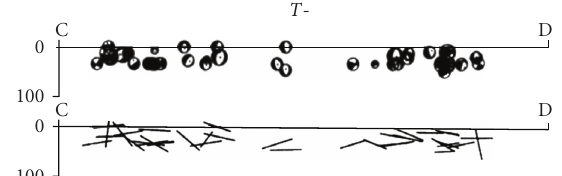
Figure 7: Projections of the vertical section along the line CD near the NW-SE direction for equal area projection diagrams and T-axes of focal mechanism solutions of events (1933–2003, M ≥ 4 . 5) in the region encircled by the dashed line in Figure